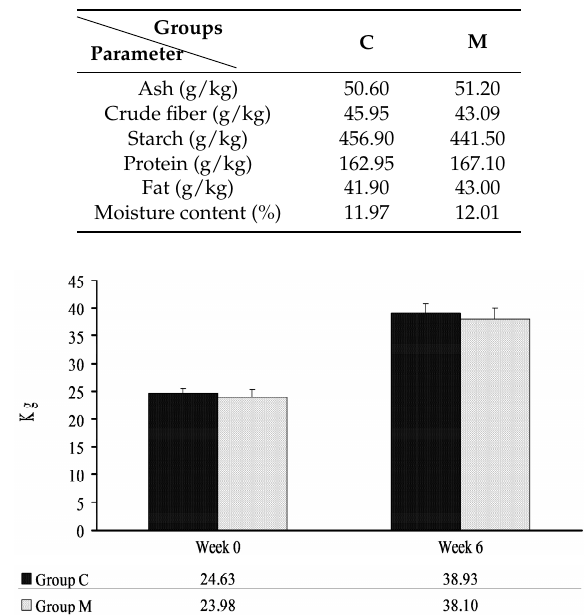
Figure 1. Body weights of pigs in weeks 0 and 6. The results were expressed as x and SD. Table 2. White blood cell counts, platelet counts, and mean platelet volume in the peripheral blood of pigs from groups C and M.